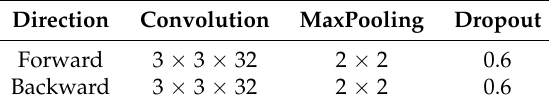
Table 4. Detailed configuration of Bi-CLSTM.